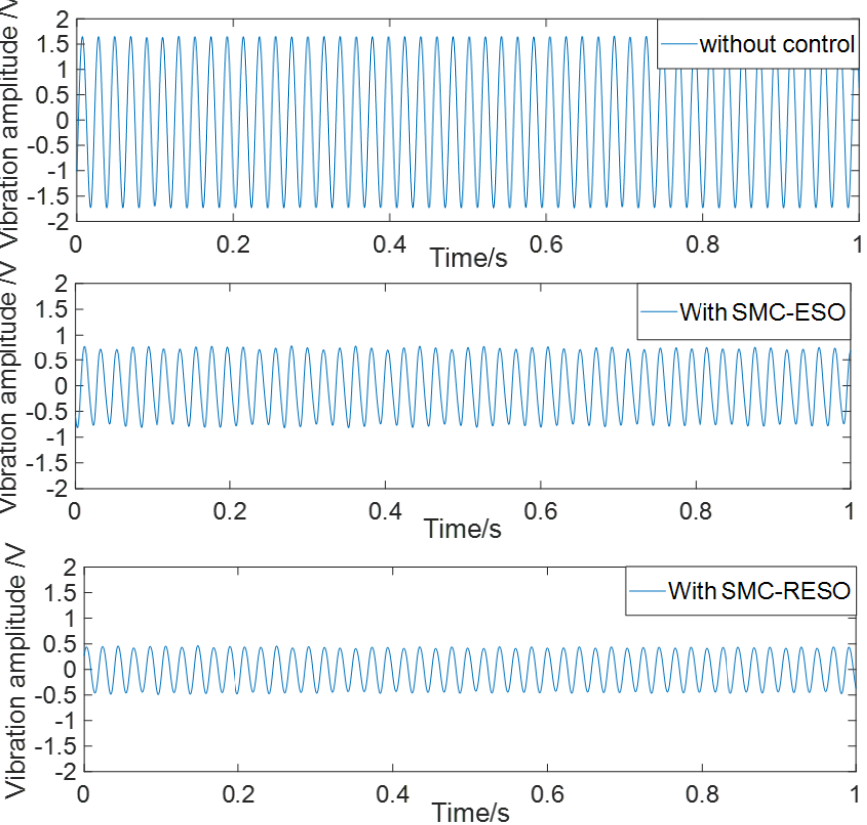
Figure 5. Time domain response.